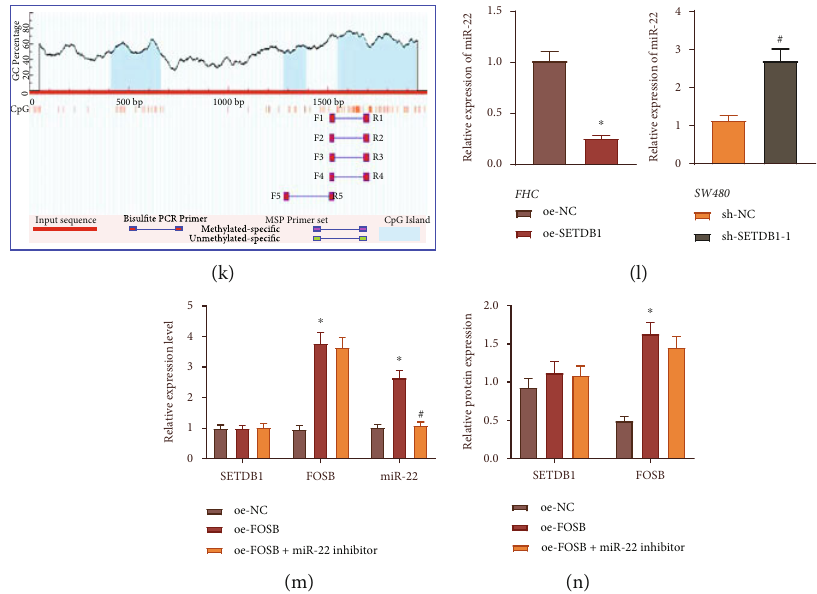
Figure 2: SETDB1 reduces miR-22 expression by downregulating FOSB. (a) The expression of FOSB in adjacent normal and CRC tissues in TCGA database analyzed by GEPIA. (b) The correlation between SETDB1 and FOSB expression was analyzed by GEPIA. (c) FOSB expression in FHC and CRC cell lines determined by RT-qPCR. (d) SETDB1 expression determined by RT-qPCR in SW480 cells treated with sh-SETDB1-1 or sh-SETDB1-2. (e) FOSB expression determined by RT-qPCR in OE-SETDB1-treated FHC cells and sh-SETDB1- treated SW480 cells. (f) Protein expression of FOSB and SETDB1 normalized to GAPDH determined by Western blot analysis in oe- SETDB1-treated FHC cells and sh-SETDB1-treated SW480 cells. (g) The enrichment of SETDB1 and H3K9me3 in the FOSB promoter region in cells detected by ChIP assay. (h) The enrichment of SETDB1 in FOSB promoter region in OE-SETDB1-treated FHC cells and sh-SETDB1-treated SW480 cells detected by ChIP assay. (i) The e ff ect of SETDB1 on the activity of the FOSB promoter region detected by dual-luciferase reporter assay. (j) Starbase was used to analyze the correlation between FOSB and miR-22 in COAD and READ datasets. (k) MethPrimer was used to analyze CpG island methylation in FOSB promoter. (l) The expression of miR-22 determined by RT-qPCR in OE-SETDB1-treated FHC cells and sh-SETDB1-treated SW480 cells. (m) The expression of SETDB1, FOSB, and miR-22 determined by RT-qPCR in cells treated with OE-FOSB or combined with miR-22 inhibitor. (n) Protein expression of FOSB and SETDB1 normalized to GAPDH in cells treated with OE-FOSB or combined with miR-22 inhibitor determined by Western blot assay. ∗ p < 0 : 05 vs. FHC cell line or FHC cells treated with OE-NC or SW480 cells treated with sh-NC. # p < 0 : 05 vs. SW480 cells treated with OE-FOSB or sh-NC. The cell experiment was run in triplicate